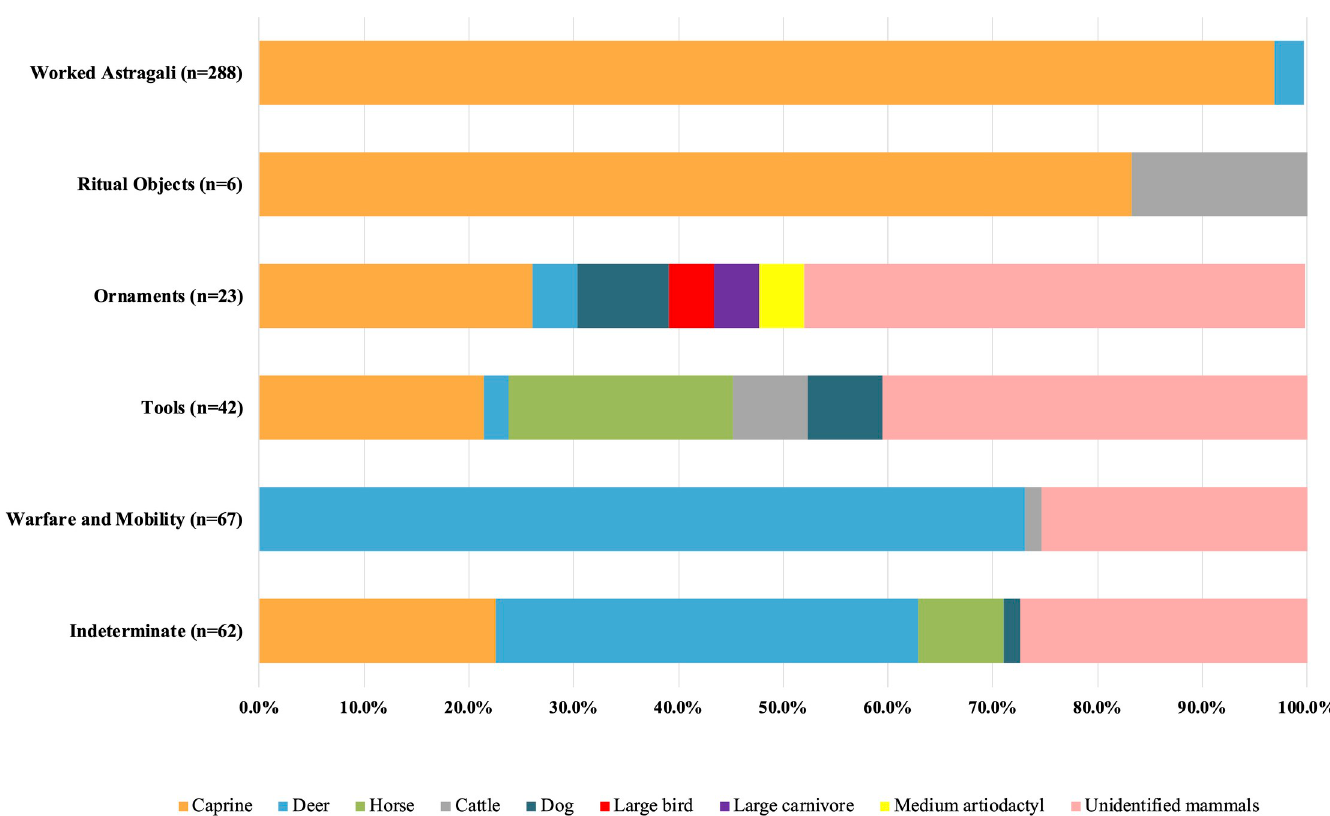
Fig 14. Raw material selection for the six categories of worked bones from